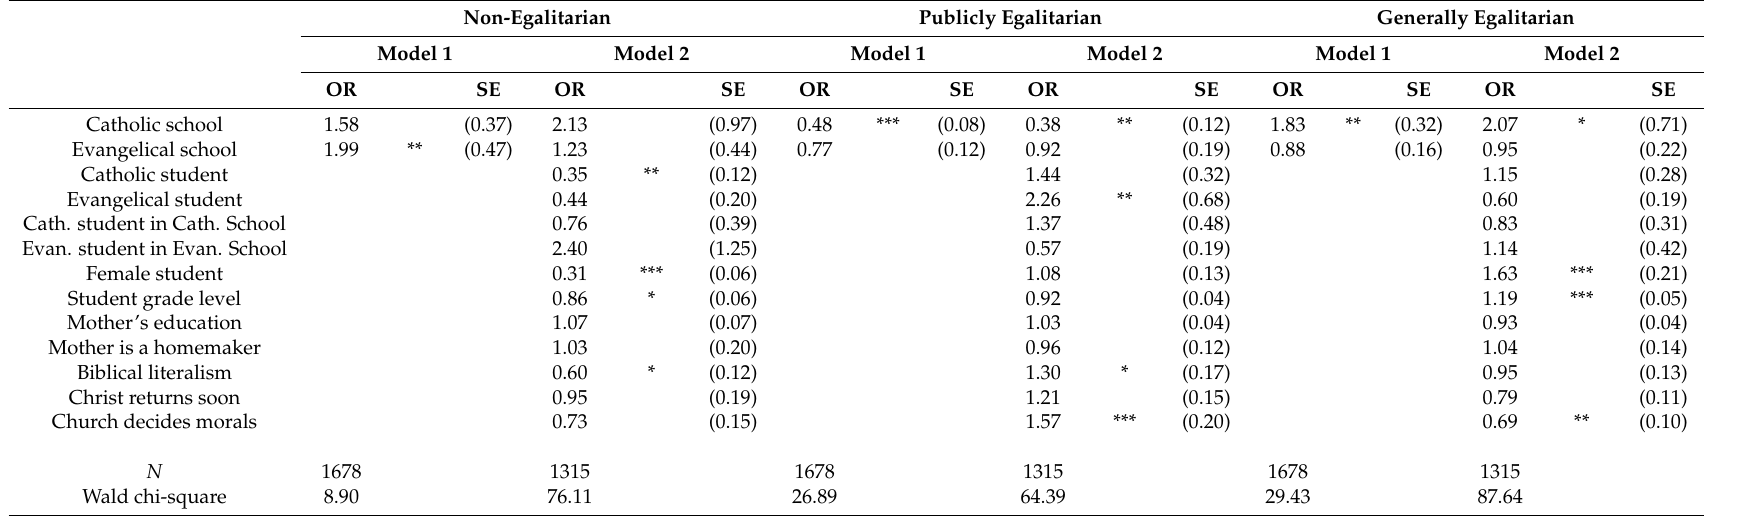
Table 6. Gender Egalitarian Predictors Hierarchical Linear